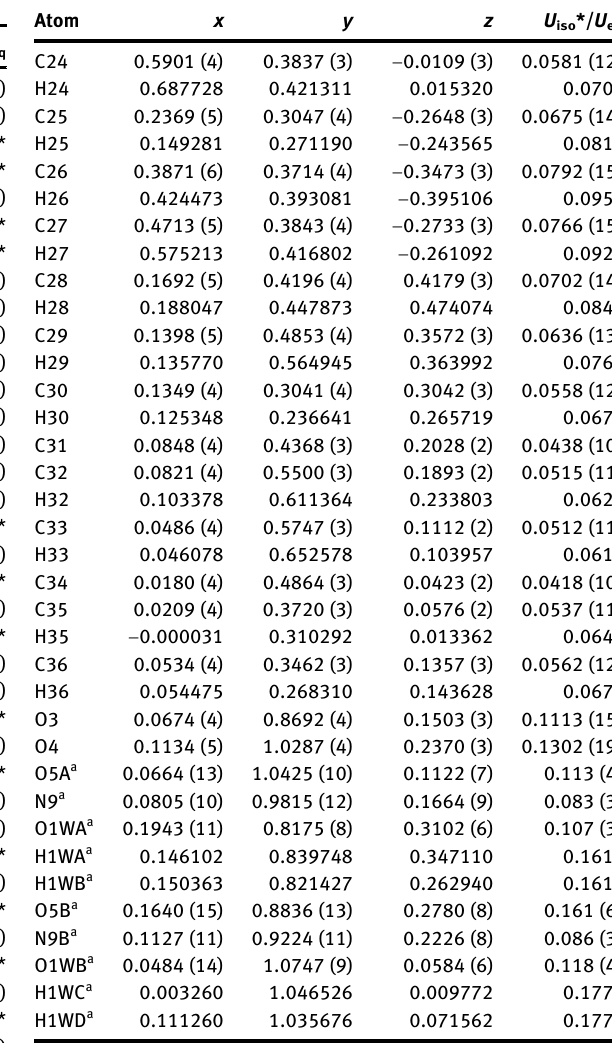
Table  : Fractional atomic coordinates and isotropic or equivalent isotropic displacement parameters (Å 